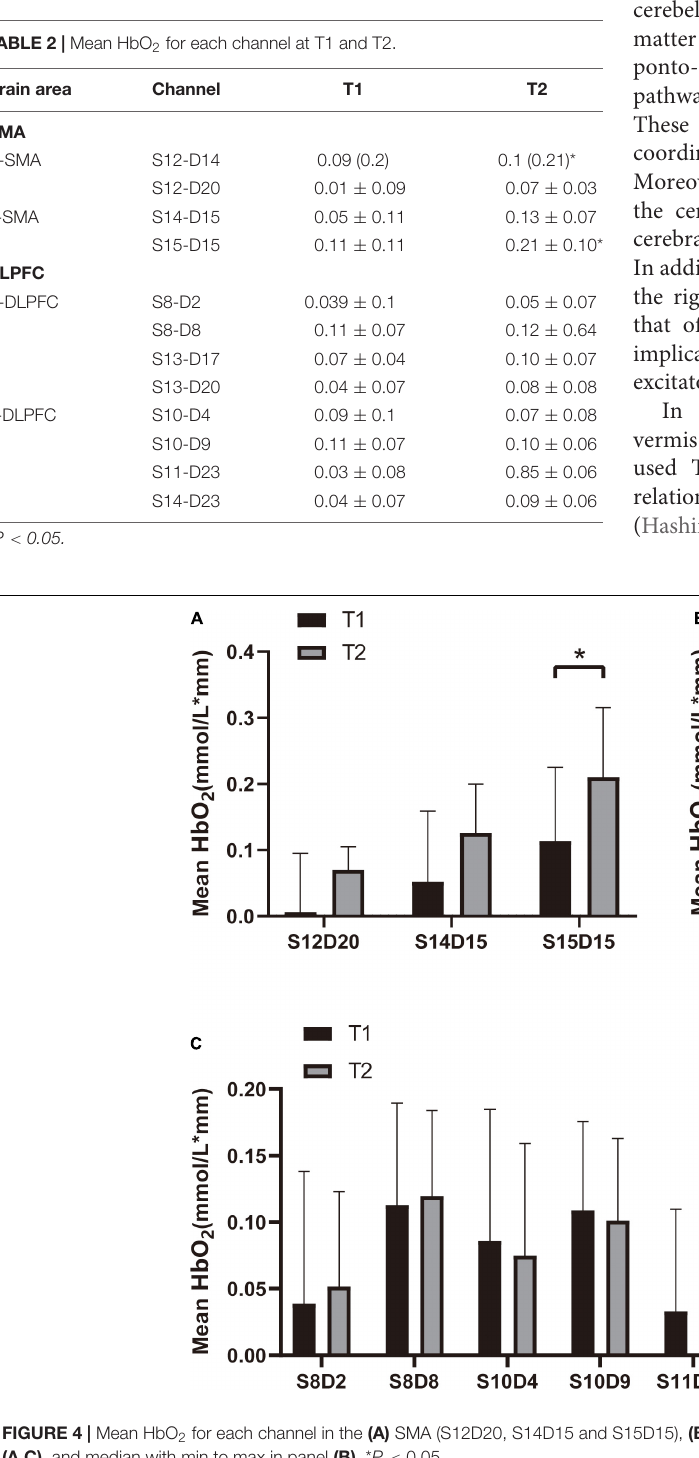
Frontiers in Human Neuroscience |